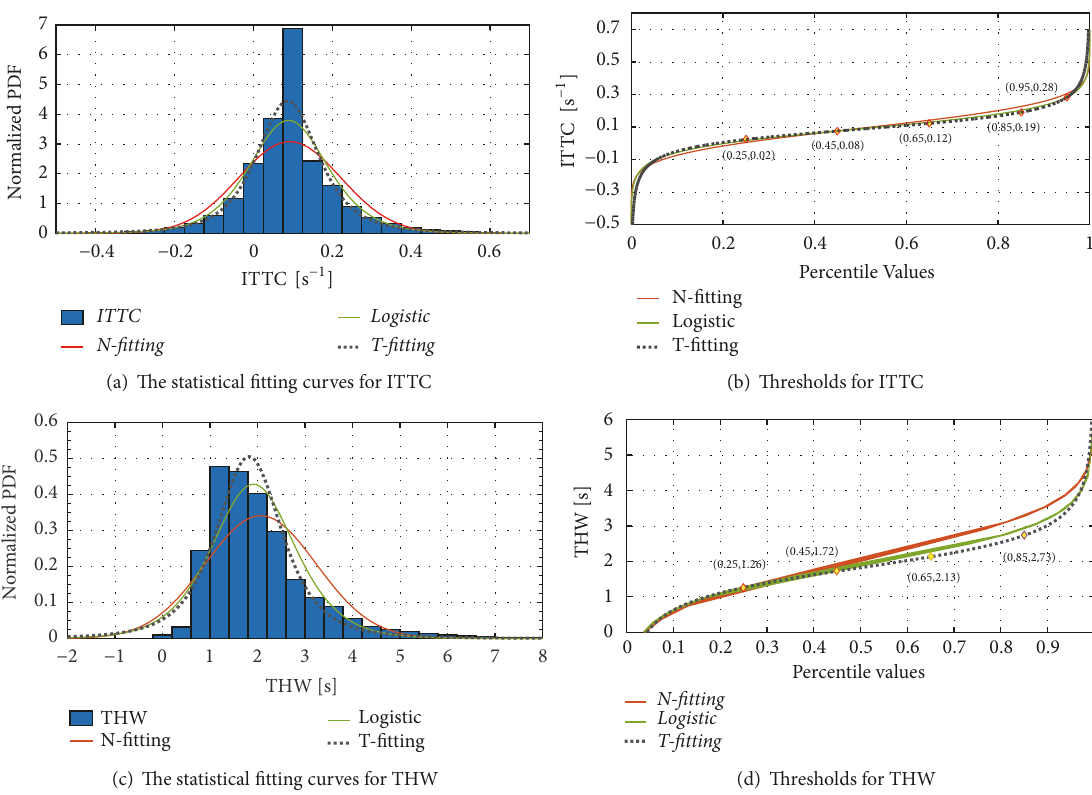
Figure 2: Fitting results and thresholds of surrogates.